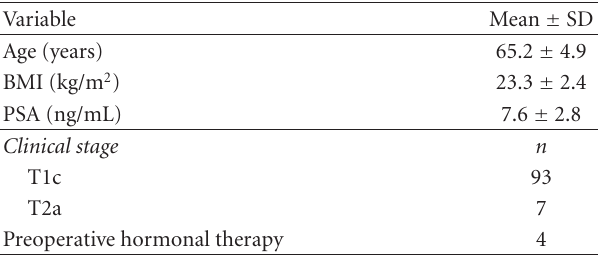
Table 1: Overall pretreatment characteristics of all 100